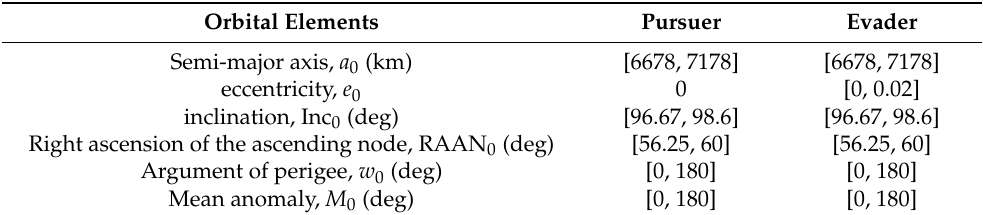
Table 2. The initial orbital ranges of the pursuit and evasion spacecraft.